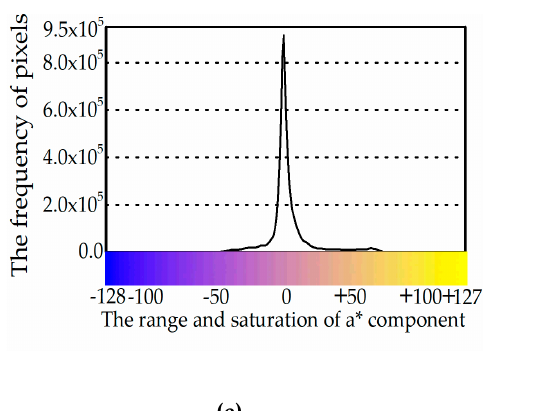
Figure 2. The details of the six-layer color quantizer.